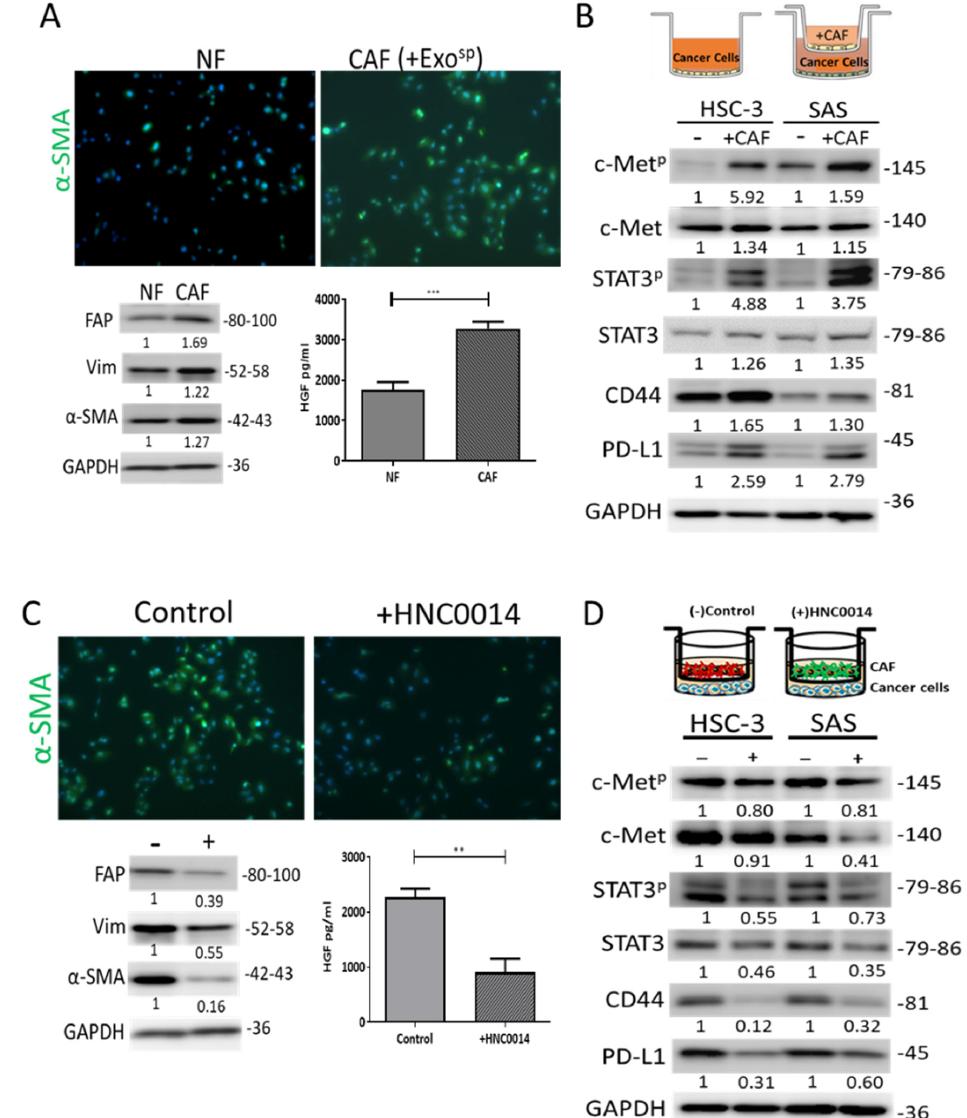
Figure 4. HNC0014 reduced Exo sp -induced CAF transformation and its protumorigenic properties in vitro. ( A ) Immunofluorescence images demonstrating the tumorsphere-derived exosome (Exo sp ) promoted CAF transformation (increased by increased α -SMA green fluorescence). Magnification 20X. Western blots (lower left panel) indicated CAF transformation reflected by the increased expressions of α -SMA, Vim, and FAP. ELISA analysis of Exo sp -transformed CAFs (lower right panel) indicated a higher level of hepatocyte growth factor (HGF) secretion than their normal fibroblast (NF) counterparts. ( B ) SAS and HSC-3 cells co-cultured with CAFs showed increased expressions of c-Met/CD44/STAT3/PD- L1 signatures. ( C ) HNC0014 treatment significantly reduced the Exo sp -mediated CAF transformation. The expression of α -SMA, Vim, and FAP was reduced in the presence of HNC0014 (lower left panel). ELISA assay showed a reduced HGF secretion by the HNC0014-treated CAF (lower right panel). Magnification 20X. ( D ) Western blots showed a decreased level of c-Met, CD44, STAT3, PD-L1, and phosphorylated forms of c-Met and STAT3 (c-Met p and STAT3 p respectively) in SAS and HSC-3 cells co- cultured with CAFs in the presence of HNC0014 . ** p < 0.01, *** p < 0.001.